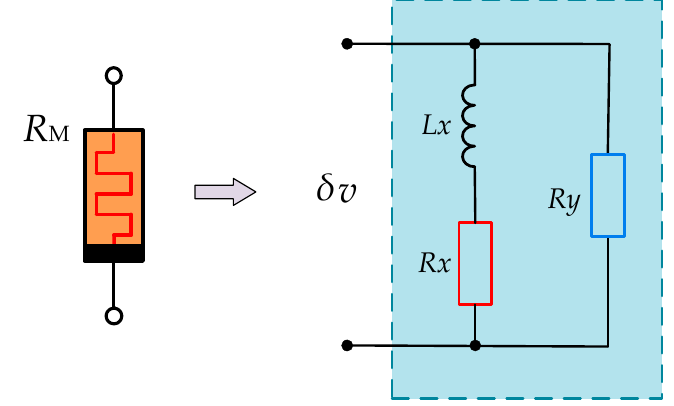
Figure 4. Small-signal-equivalent circuit of the memristor. Through the zero-pole simplification of admittance function Y ( s , Q), the small-signal admittance Y ( s , Q) in terms of the pole s = P and the zero s = Z can be recast as